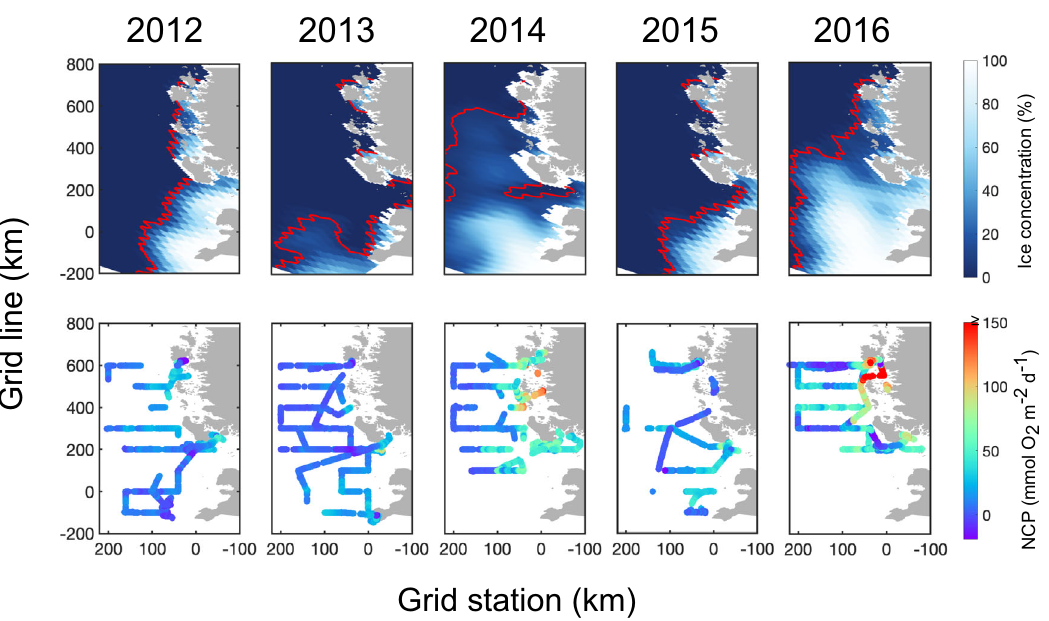
Fig. 2 Spatial patterns of summer WAP ice concentrations and NCP from 2012 to 2016. January averaged sea-ice concentrations derived from passive microwave satellite measurements ( top ). Red contours represent the biologically relevant ‘ ice-edge ’ de fi ned as an ice concentration threshold of 5%. Underway estimates of NCP using O 2 /Ar method from the annual PAL-LTER sampling cruises along the WAP grids ( bottom